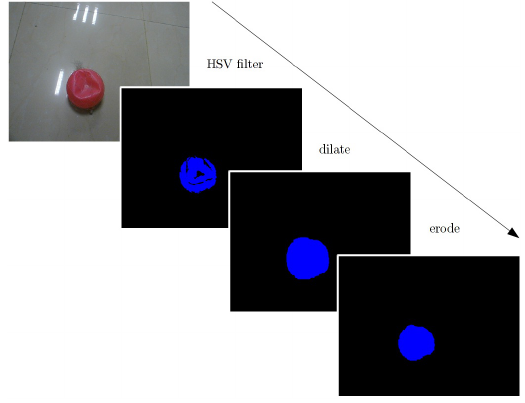
Figure 6. Extract interesting color with HSV filter.